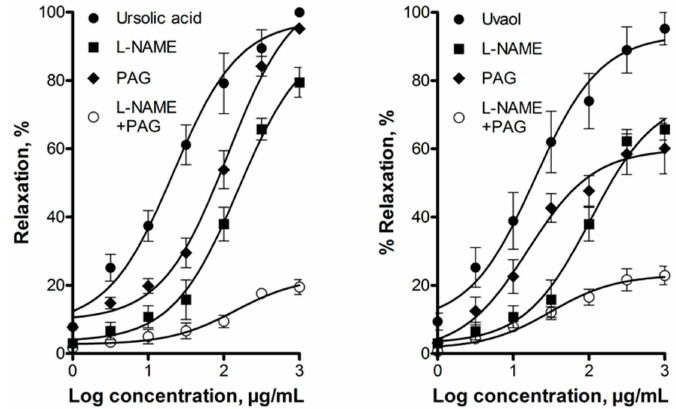
Figure 5. Vasodilatory effect of ursolic acid and uvaol in the absence (control) and presence of inhibitors of enzymes that produce gasotransmitters: L -NAME (1 µ M), PAG (1 mM), and L -NAME (1 µ M) + PAG (1 mM). Analysis by repeated-measures two-way ANOVA was made between the curves of each triterpene in the presence of L -NAME, PAG or L -NAME + PAG ( p <